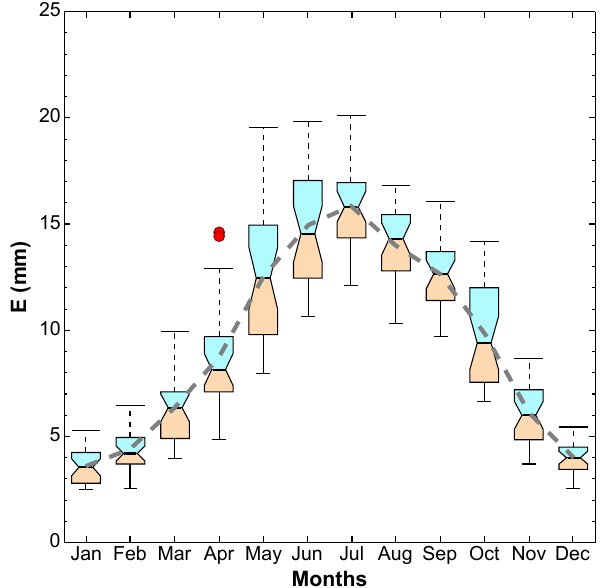
Figure A6. Notched boxplots show the daily variability of evaporation for each month; the dashed line shows the mean values.